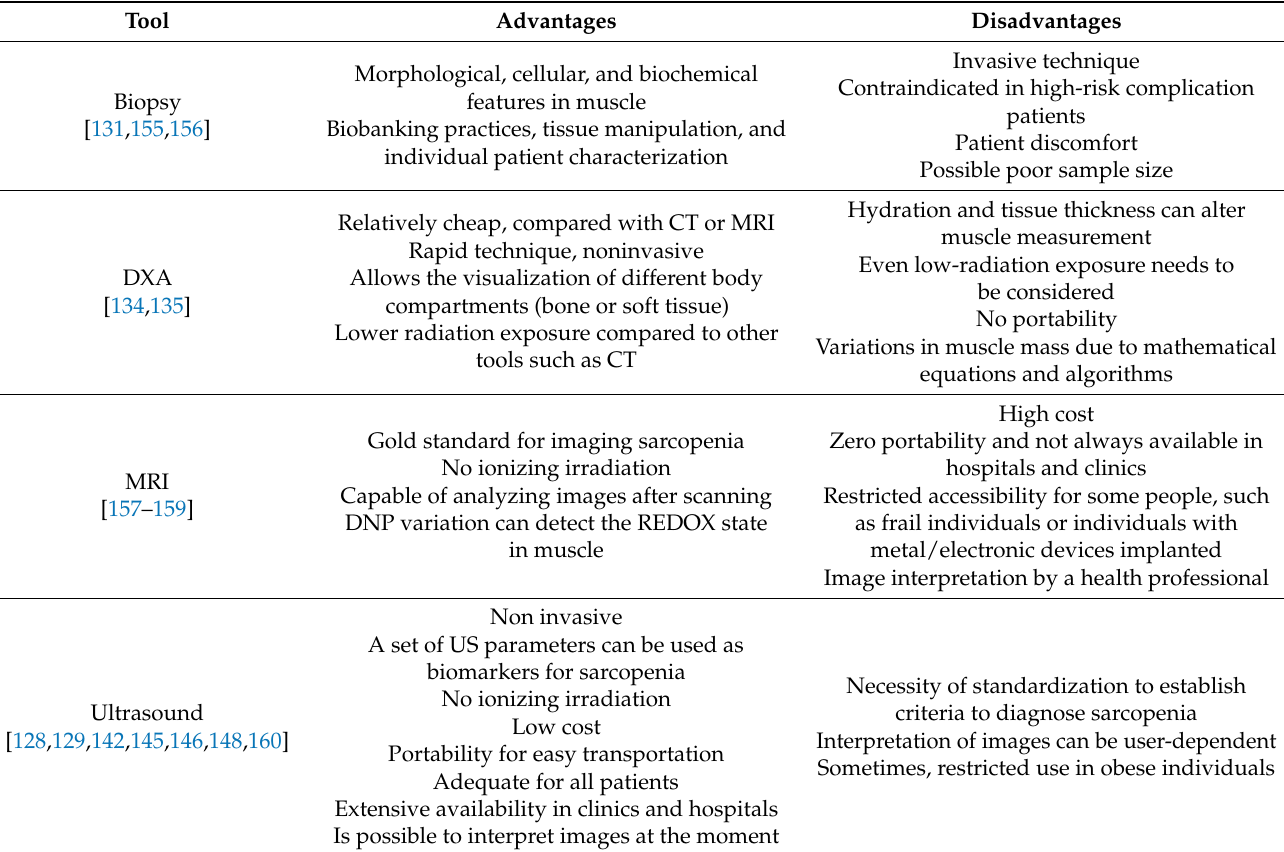
Table 2. Comparison of advantages of imaging tools used for sarcopenia. US, DXA, and MRI have their own perks; nevertheless, US could become a gold standard for diagnosis and follow-up in sarcopenia due to its low cost and almost universal use in clinical